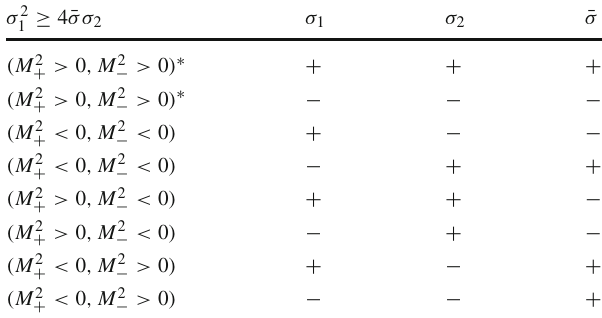
Table 1 Tachyon-free conditions in parameter